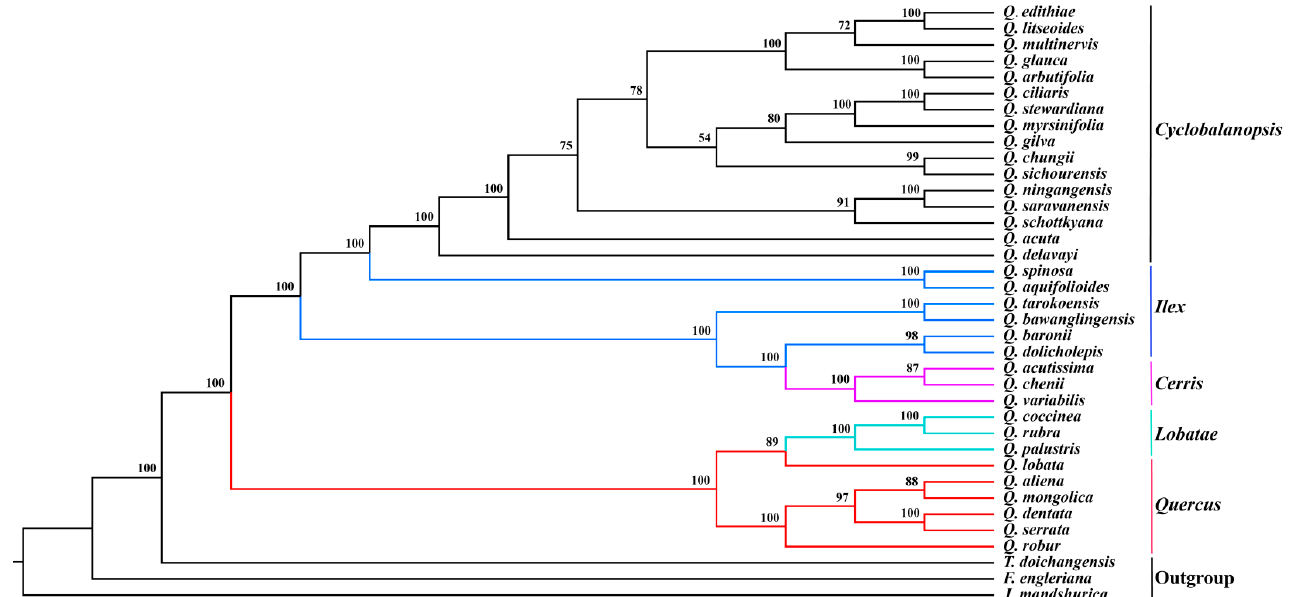
Figure 5. The phylogenetic tree among 37 chloroplast genome homologous sequences is based on the ML method. Values besides the branch represented bootstrap support (BS). Abbreviations: Quercus ( Q. ), Trigonobalanus ( T. ), Fagus ( F. ), and Juglans ( J. ).